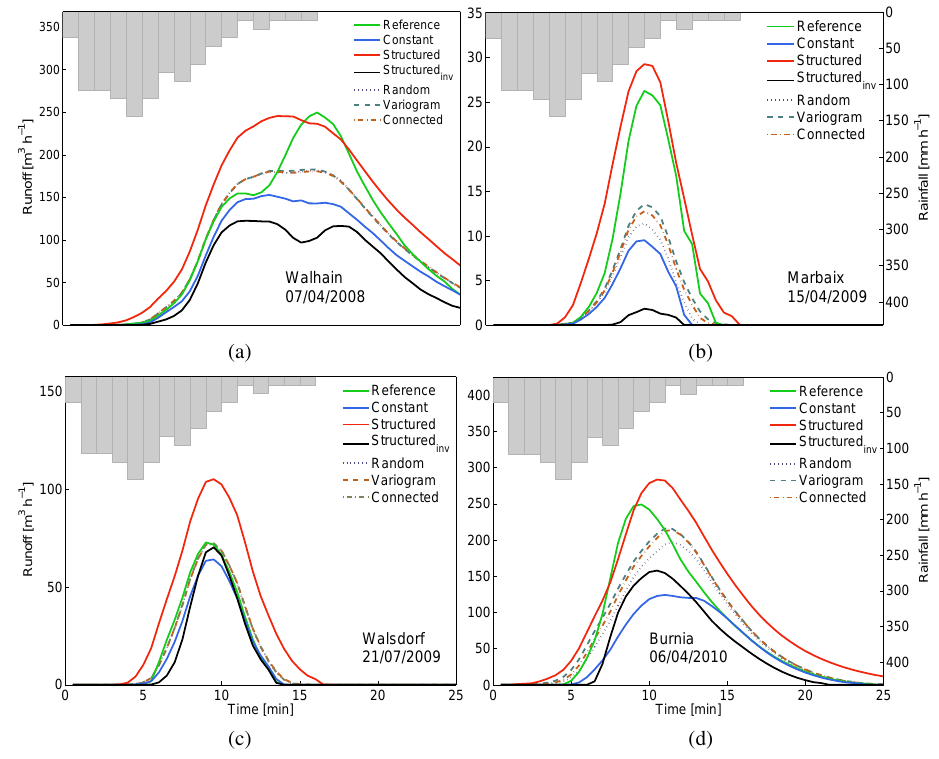
Fig. 4. Hydrographs from hydrologic simulations using the antecedent soil moisture maps from all scenarios for 4 field campaigns: Walhain – 07/04/2008 (a) , Marbaix – 15/04/2009 (b) , Walsdorf – 21/07/2009 (c) and Burnia – 06/04/2010 (d) . For stochastic soil moisture scenarios, i.e., Random , Variogram , Connected , the average hydrographs on the 1000 realisations are depicted. The rainfall is depicted by the bars of the second Y-axis.